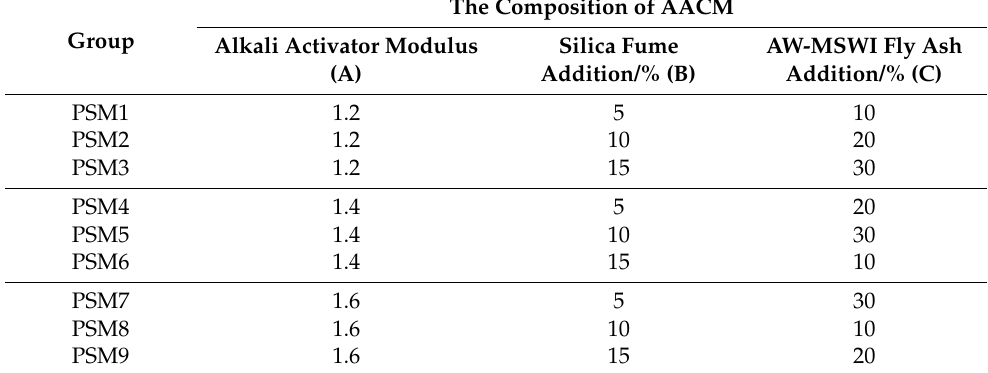
Table 2. Orthogonal test table.